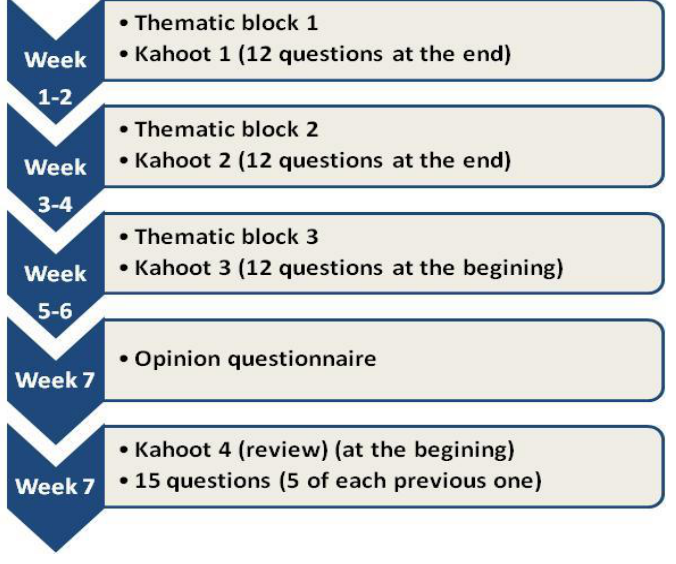
Fig. 1. Phases in the